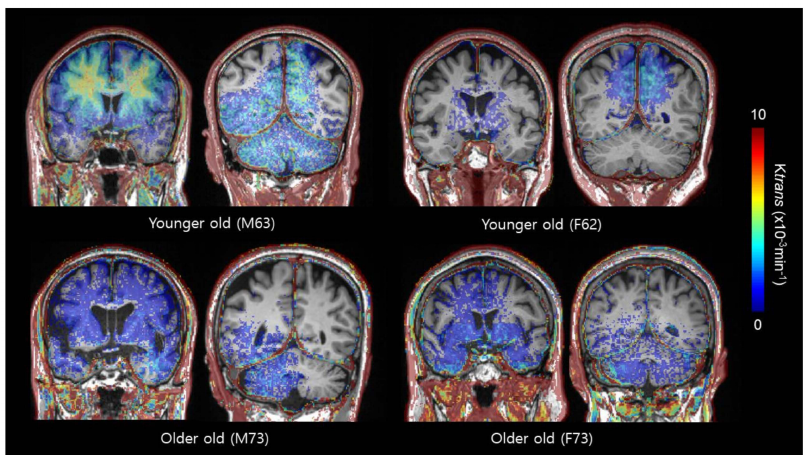
Figure 2. Exemplary cases of BBB permeability imaging (K trans ) by sex and age group. Higher BBB permeability in the cingulate and occipital cortex is noted in male subjects compared to female